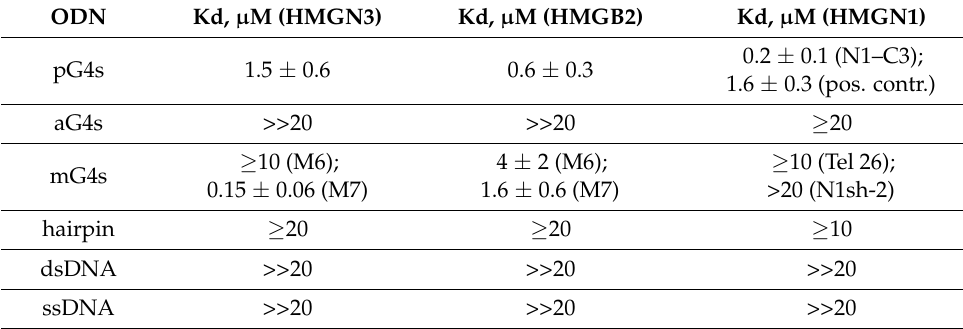
Figure 7. G4-HMG protein interactions and their possible contributions to CTCF positioning. ( A ) Microscale thermophoresis (MST)-based analysis of HMG proteins interactions with representative sequences that comply with enriched motifs (G4s and duplexes), the control hairpin and single-stranded oligonucleotides. Conditions: 50 nM labeled protein, 0–20 µ M oligonucleotide, 140 mM potassium-phosphate buffer, pH 7.2 (6.7 for the i-motif N1-3). ( B ) Venn diagrams illustrating the overlaps between G4-ChIP-seq (BG4) peaks, HMGN3-bound sites, and CTCF-bound sites in K562 (left); G4-seq peaks, HMGB2-bound sites, and CTCF-bound sites in IMR-90; and G4-seq peaks, HMGN1-bound sites, and CTCF-bound sites in CD4+ T-cells. Table 1. Summary of HMG protein interactions with G4s and control oligonucleotides.